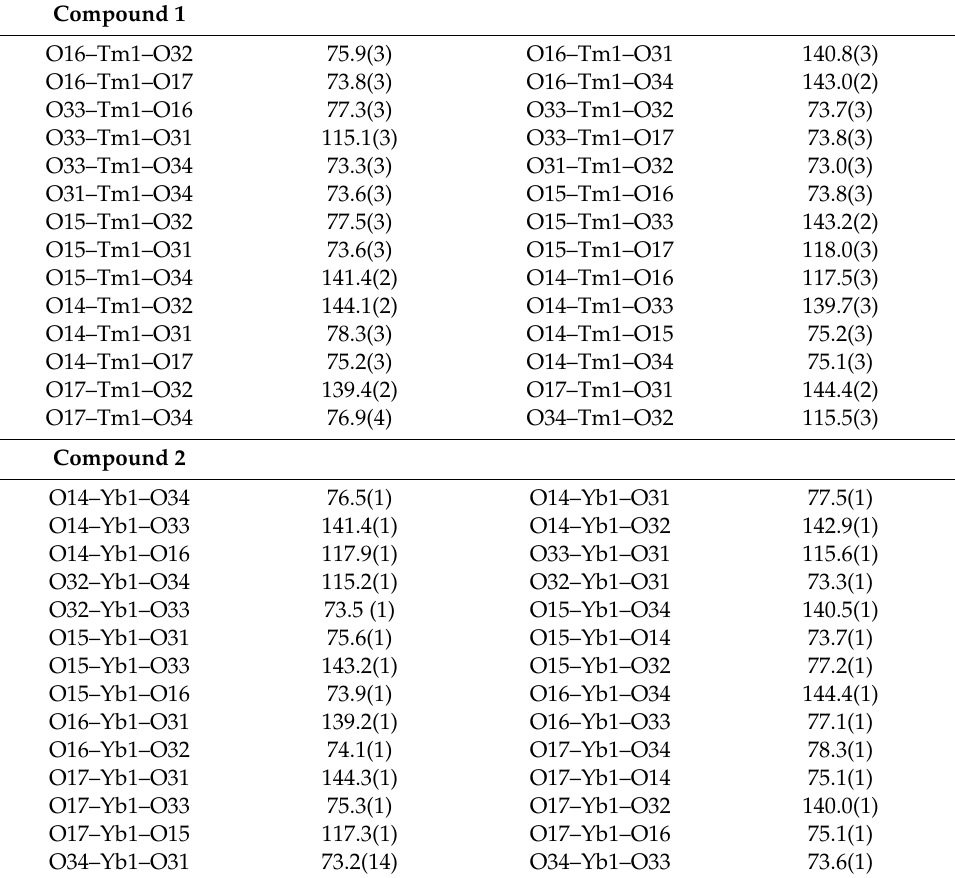
Table 3. Selected bond angles of 1 and 2 ( ◦